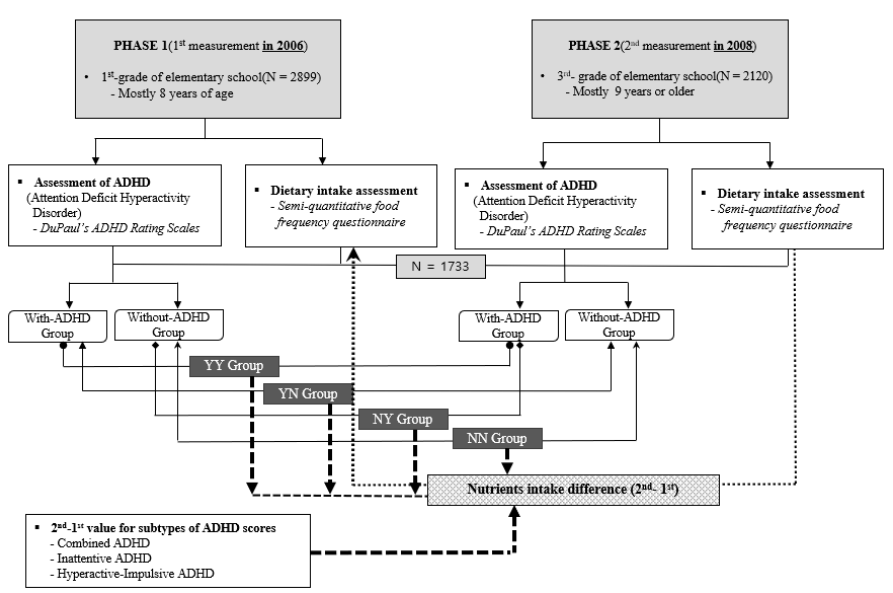
Figure 1. Flow chart of study 2.3. Primary outcome measure: ADHD scores.